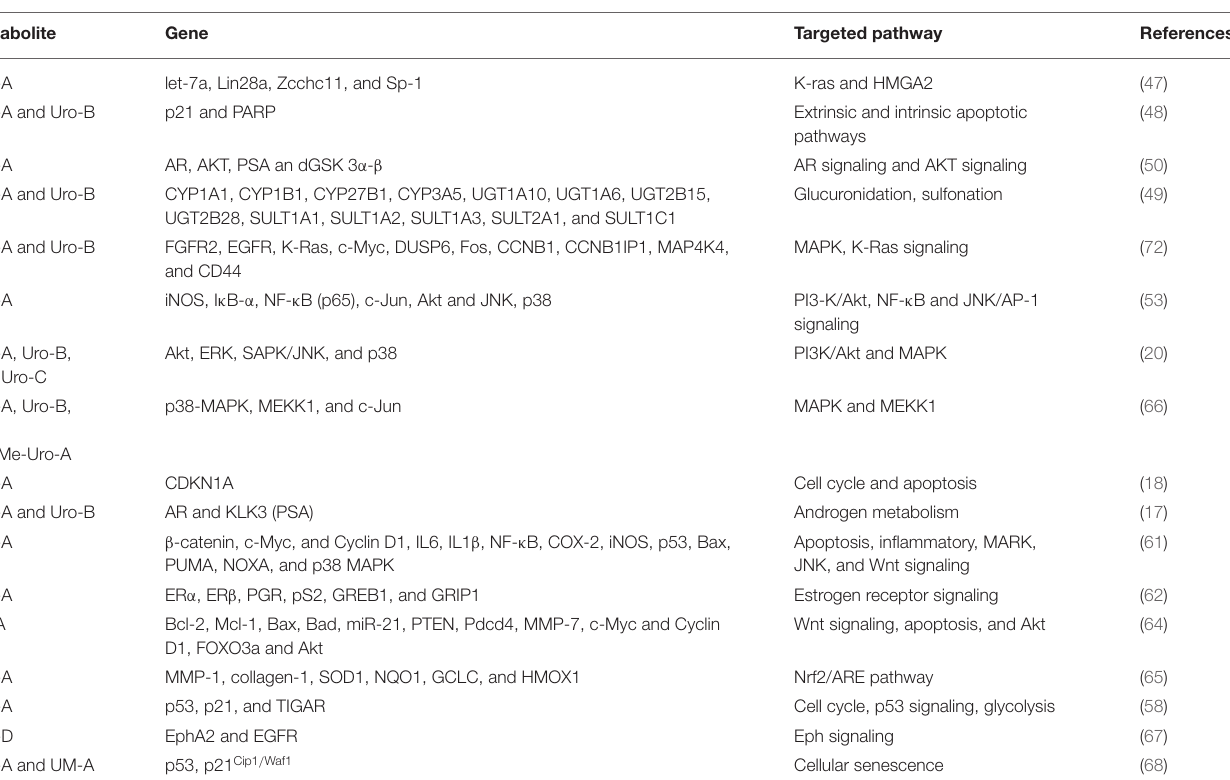
TABLE 2 | Urolithins targeted genes and their